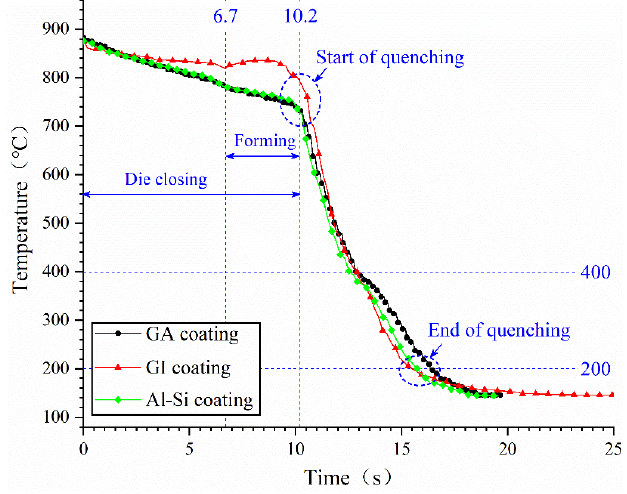
Figure 11. The temperature variation curves of the three coatings under the same forming-quenching process. Table 3. The parameters of temperature variation curves in Figure 11.